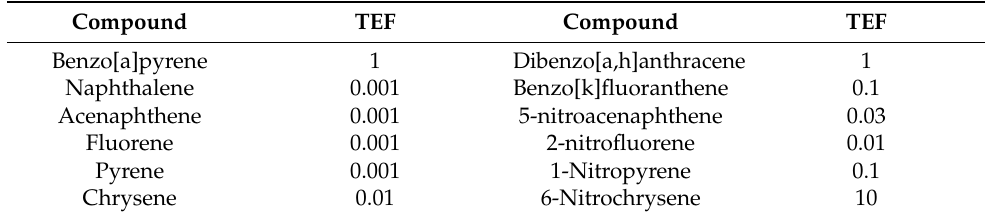
Table 3. TEF factors of selected micro-contaminants